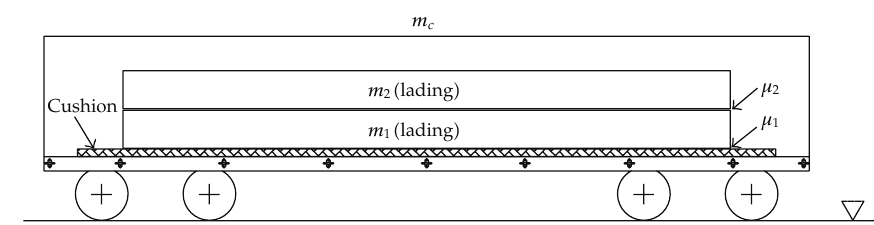
Figure 3: Load support and load securement method.